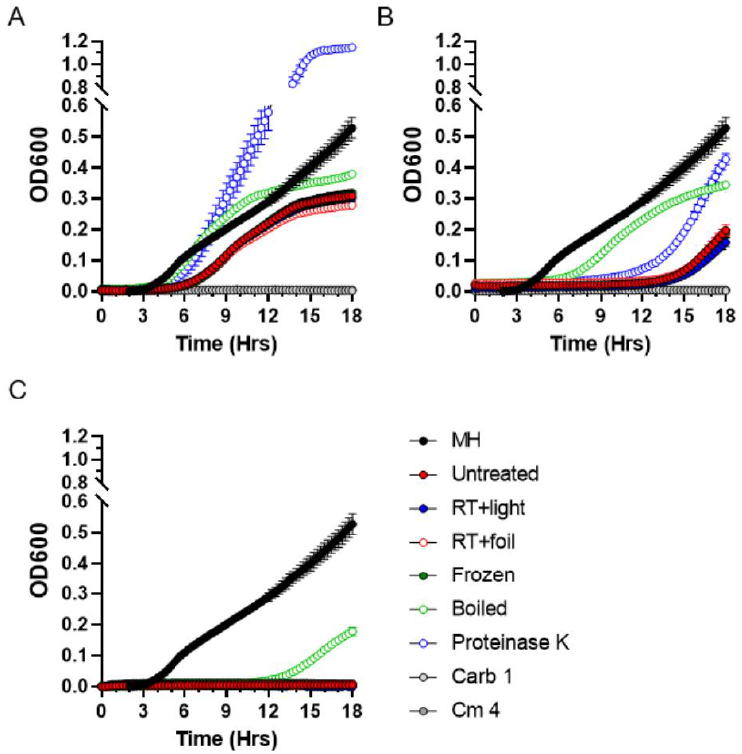
Figure 6. Residual antibacterial activity of P. patens exudate after different treatment regimens . Residual activity of exudate from four-week-old P. patens Gd culture was tested by MIC assays against S. aureus following treatments for temperature (Frozen, Boiled) and light/dark (RT + light, RT + foil) sensitivity, as well as proteinase K treatment. Residual activity was tested at exudate con- centrations 6.25 mg/mL ( A ), 12.5 mg/mL ( B ) and 25 mg/mL ( C ). Carbenicillin (Carb, 1 µg/mL) and chloramphenicol (Cm, 4 µg/mL) were used as positive controls. MH — S. aureus growth in liquid MH medium without exudate addition. 2.5. Size Fractionation of Bioactive Exudate Metabolites To determine the approximate molecular weight range of secreted antimicrobial P. patens compounds, we performed a size fractionation experiment using the Amicon Ultra- 15 ultrafiltration system (3 kDa and 10 kDa molecular weight cutoffs). Following size frac- tionation, MIC data indicated that antibacterial activity against S. aureus was completely lost in the largest >10 kDa fraction (Figure 7A). In contrast, antibacterial activity was fully retained in the smaller 3 – 10 kDa size fraction (Figure 7B) and also to some degree in the smallest < 3 kDa fraction (Figure 7C). Specifically, the MIC value of the most active 3 – 10 kDa fraction (25 mg/mL) was only 2-fold less than that of the unfractionated Gd exudate (Figure 4B). Overall, these data indicate that the apparent molecular weight of the bioac- tive P. patens exudate compounds is less than 10 kDa, which correlates well with their presumed peptide or small protein nature determined through proteinase K and boiling sensitivity assays.